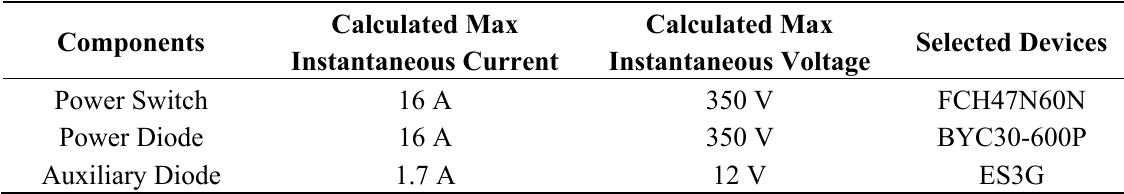
Table 3. Power devices